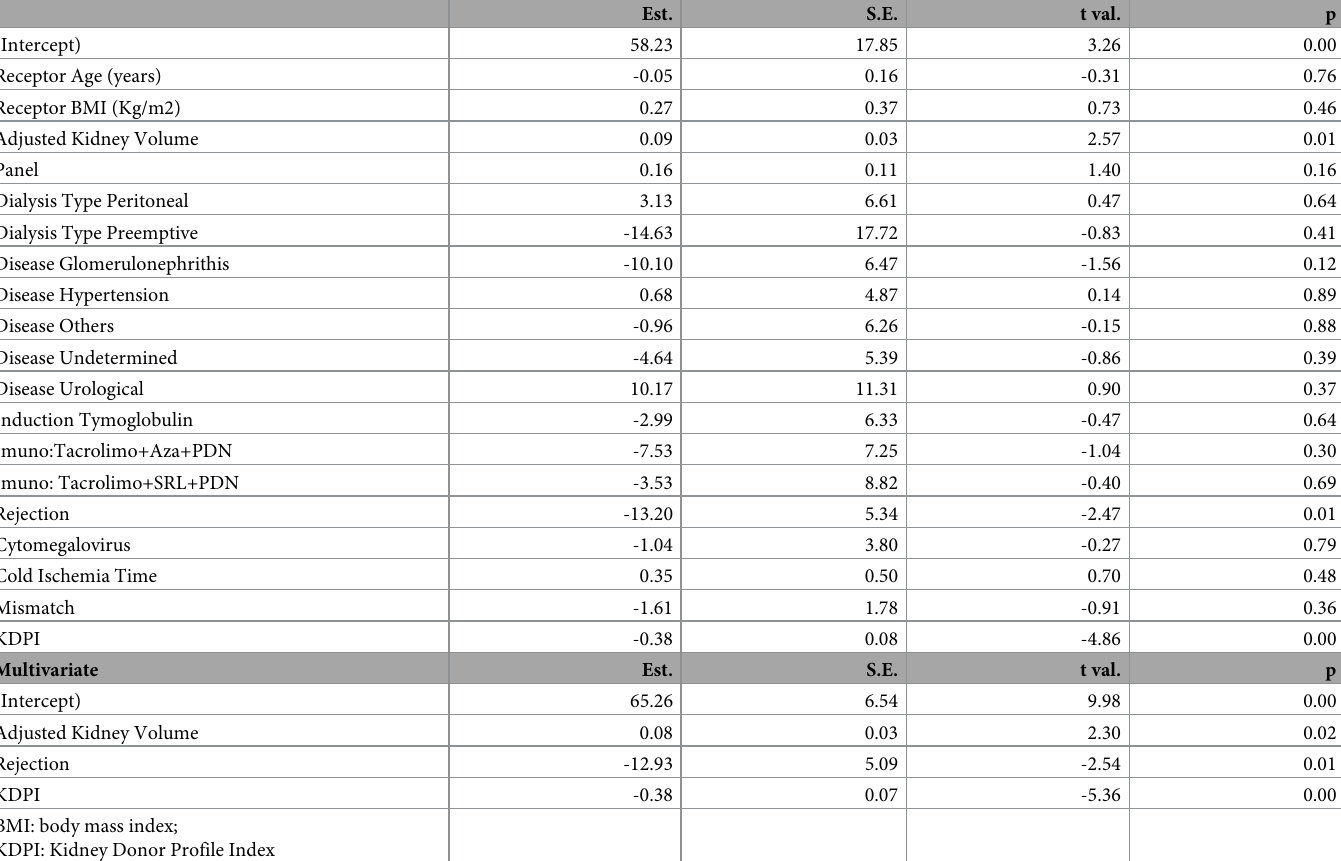
Table 3. Linear regression—univariate and multivariate analysis of factors associated with better eGFR at the end of the first year in the deceased donor group.